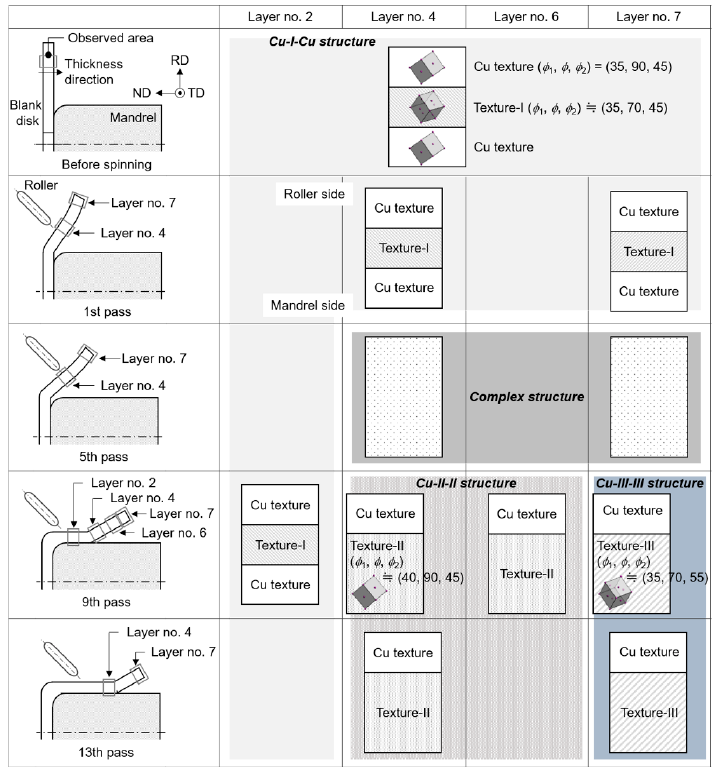
Figure 7. Evolution of the layer structure characterized by the textures with spinning process. Four types of layer structures were obtained by the conventional spinning process: Cu-I-Cu, Cu-II-II, Cu-III-III, and complex types. The Cu texture was {112} < 111 > . Texture-I rotated 20 ◦ around its < 111 > from the Cu texture. Texture-II rotated 5 ◦ around its < 110 > from the Cu texture. Texture-III rotated 10 ◦ around its < 001 > from fiber